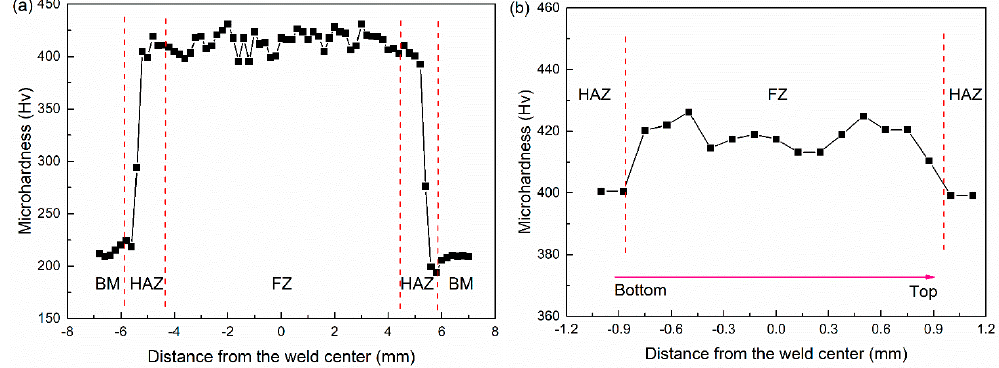
Figure 8. Microhardness distribution of the spot-welded joint: ( a ) In longitudinal direction; ( b ) In thickness direction.